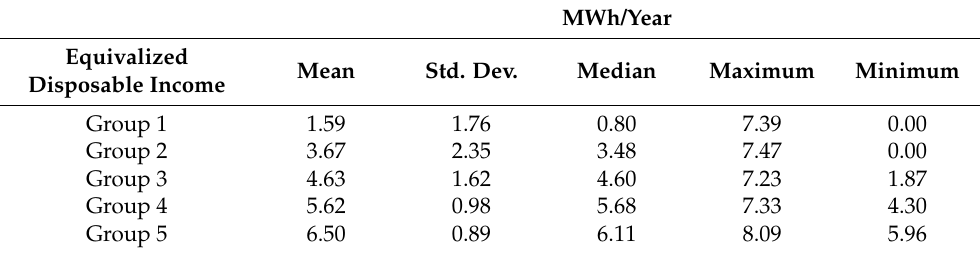
Table 6. Statistical data of household consumption without the influence of